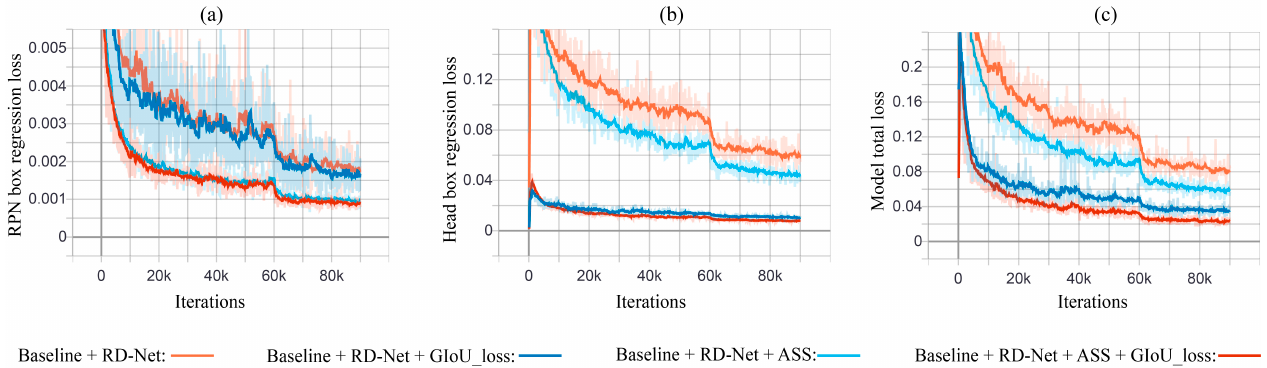
Figure 7. ( a ) RPN box regression loss; ( b ) classification and detection head box regression loss; ( c ) total loss for the models with RD-Net backbone.